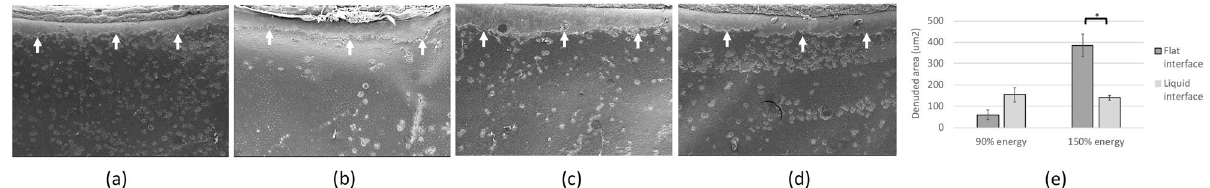
Figure 2. Representative electronic microscopy images showing the endothelial denuded area (arrows) with different interfaces and different levels of energy qualitatively and quantitatively: flat interface with 90% energy